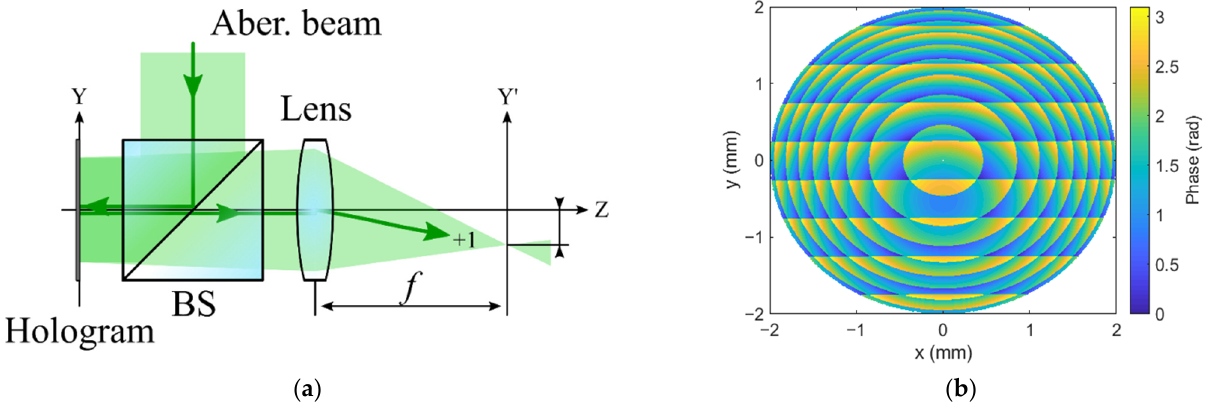
Figure 2. ( a ) Principle of operation CGH; ( b ) distribution of the phase argument of the